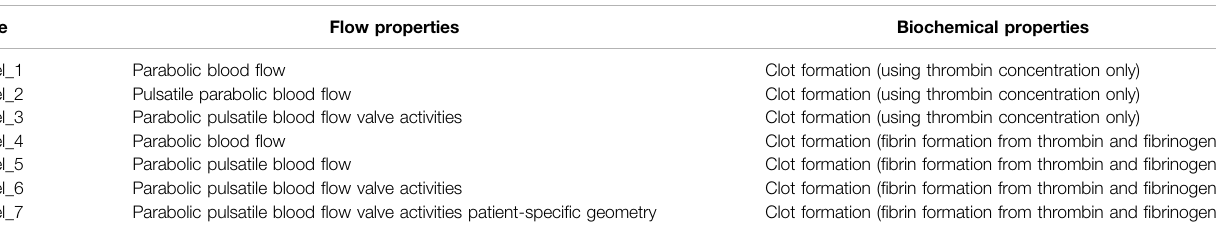
TABLE 3 | Simulations carried out to study the clot initiation and propagation as the complexity of the model increases (3D